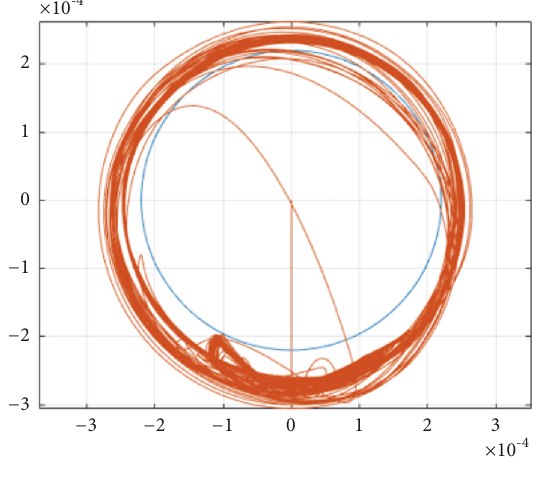
Figure 36: Predicted rotor NDE node orbit.